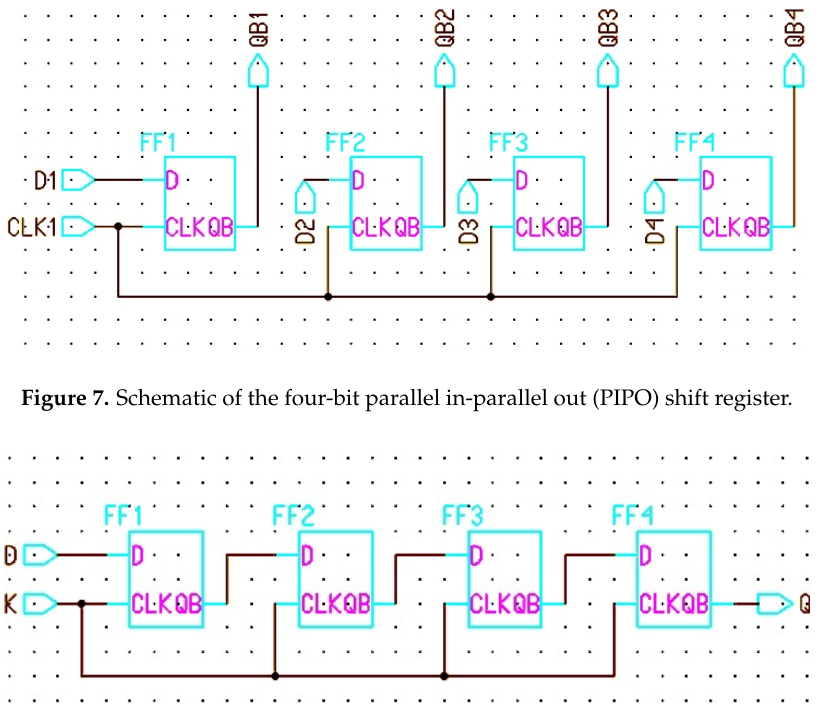
Figure 9. Simulation results of the C ‐ element.